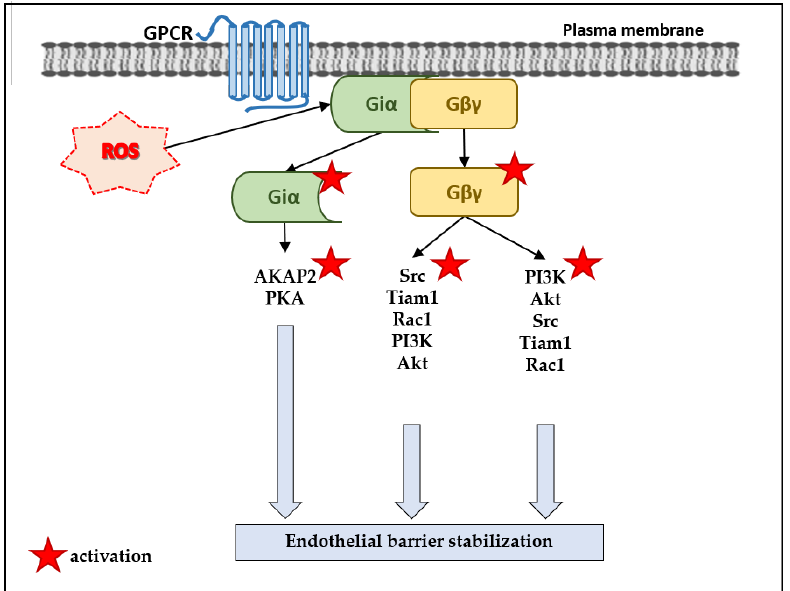
Figure 3. Scheme illustrating the potential mechanisms for enhancement of the endothelial barrier via ROS-induced and G i -PCR-independent activation of the Gα i proteins and liberation activation of the Gβγ dimers, which can further activate the AKAP2–PKA, Rac1, and the PI3K–Akt